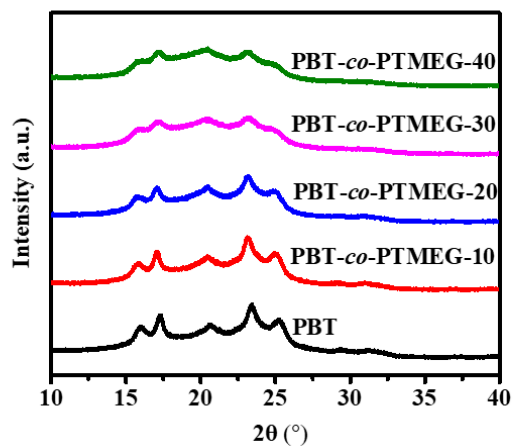
Figure 5. XRD patterns of PBT and PBT- co -PTMEG copolymers.